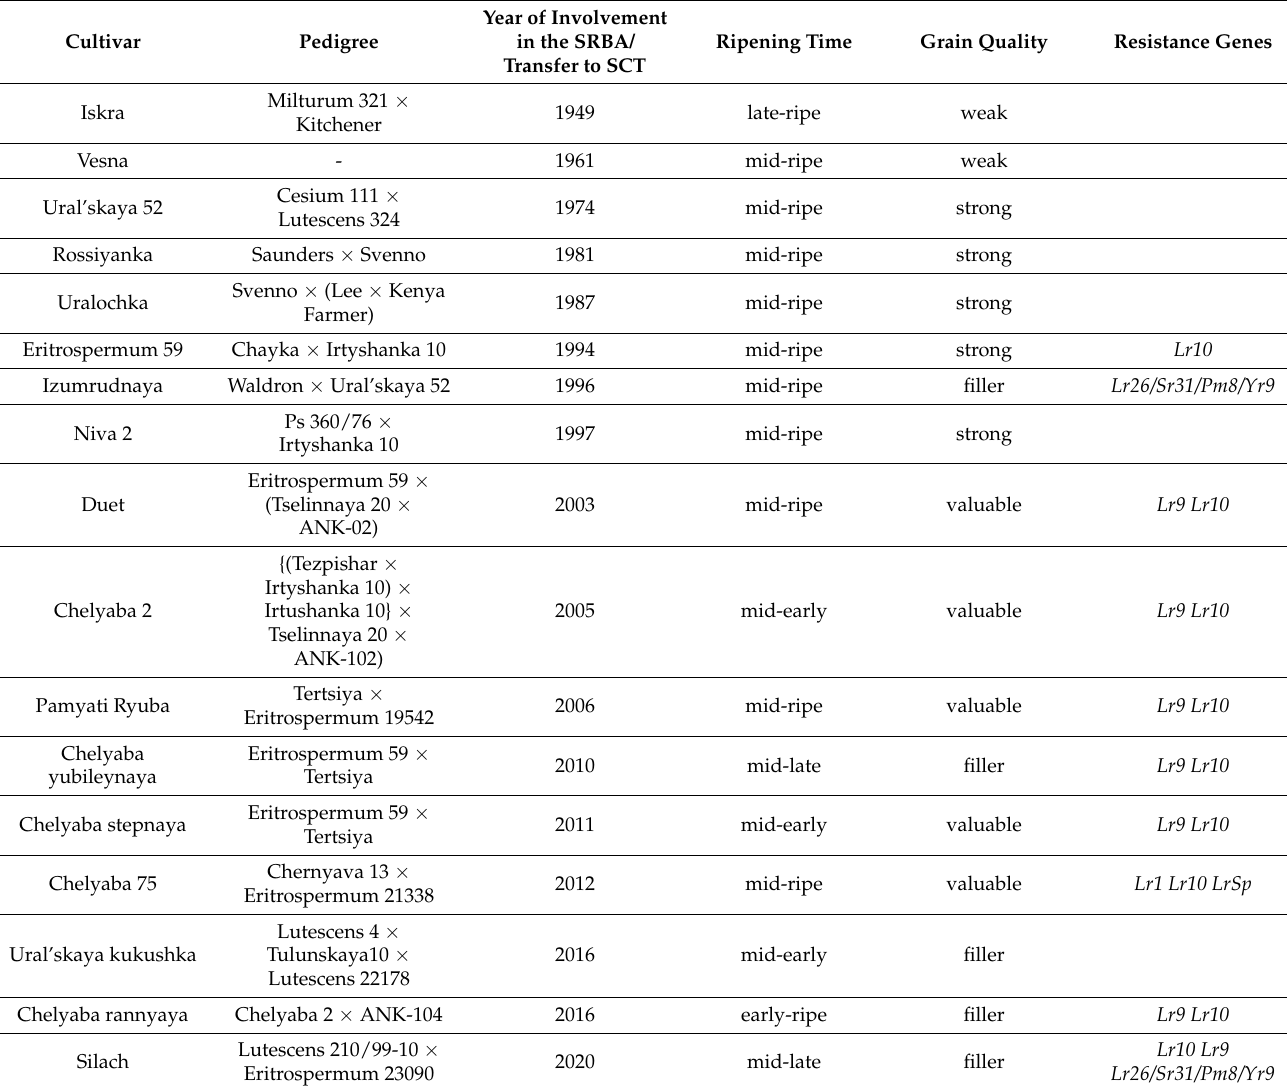
Table 1. Cultivars of the Chelyabinsk Research Institute of Agriculture included in the State Register of Breeding Achieve- ments (SRBA) and promising cultivars progressed to State Cultivar Testing (SCT). Year of Involvement Cultivar Pedigree in the SRBA/ Ripening Time Grain Quality Resistance Genes Transfer to SCT Milturum 321 × Iskra 1949 late-ripe weak Kitchener - 1961 mid-ripe